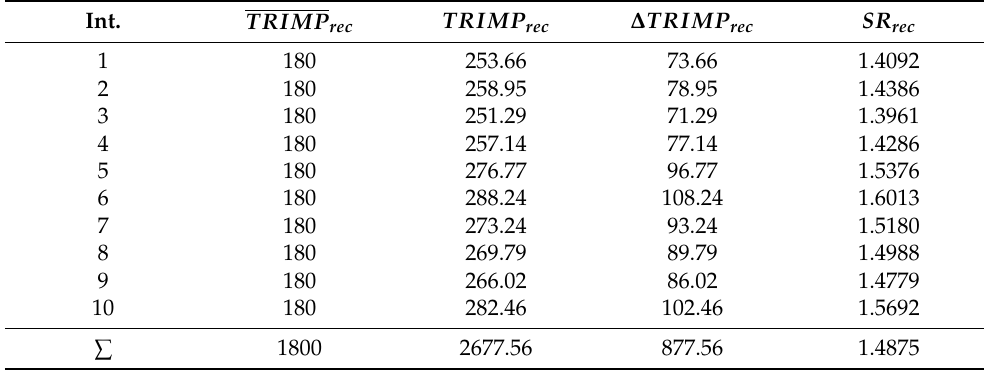
Table 6. Amateur cyclist results by interval recovery